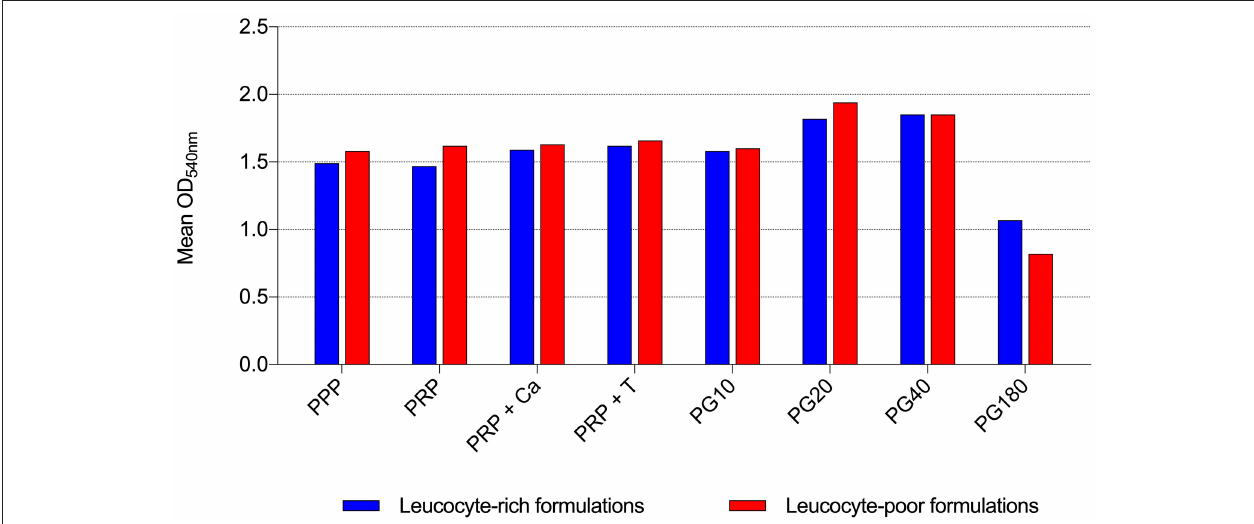
FIGURE 7 | Mean OD 540nm values of leukocyte-rich formulations and leukocyte-poor formulations observed after 18h of incubation in the presence of different non-transfusional hemo-components. PPP, platelet-poor plasma; PRP, platelet-rich plasma; PRP + Ca, platelet-rich plasma with calcium gluconate; PRP + T, platelet-rich plasma with thrombin-rich solution; PG10, platelet gel 10 µ l; PG20, platelet gel 20 µ l; PG40, platelet gel 40 µ l; PG180, platelet gel 180 µ l.